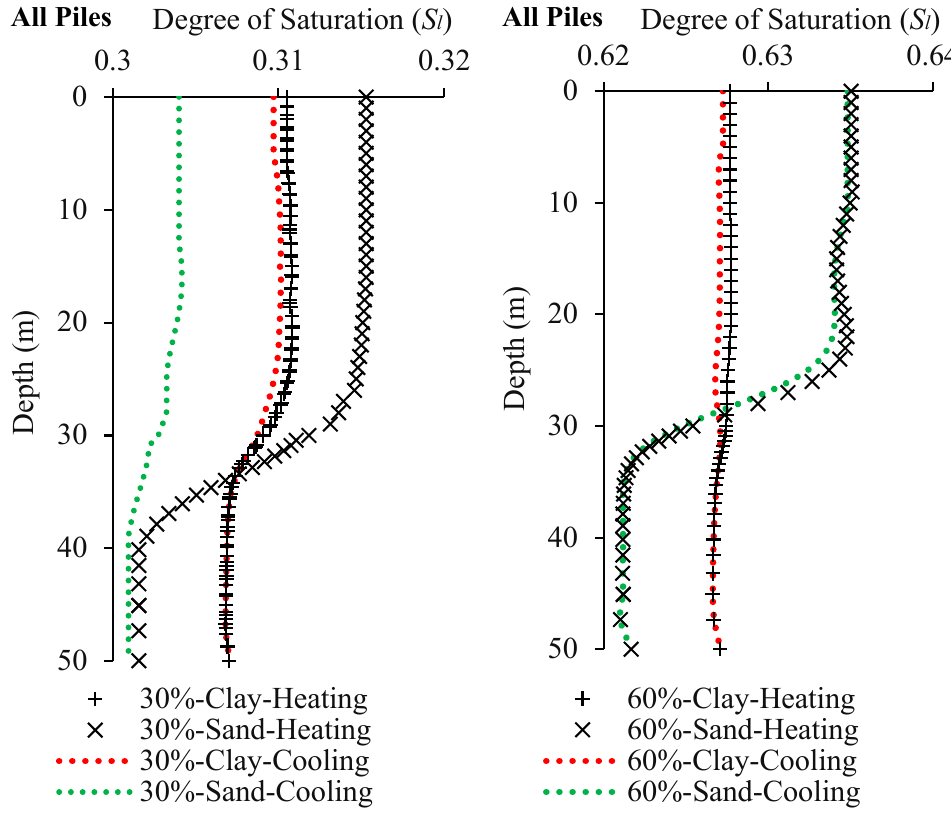
Figure 13. The results of the degree of saturation with depth for the cyclic heating and cooling of all GEPs in the group .